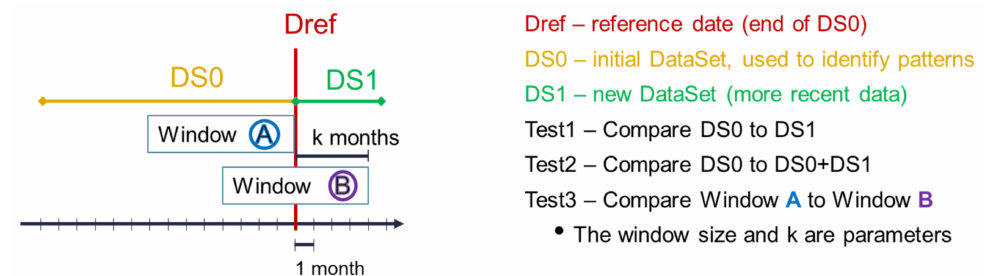
Figure 6. Subdivision of the consumption time series to perform the test scale changes.